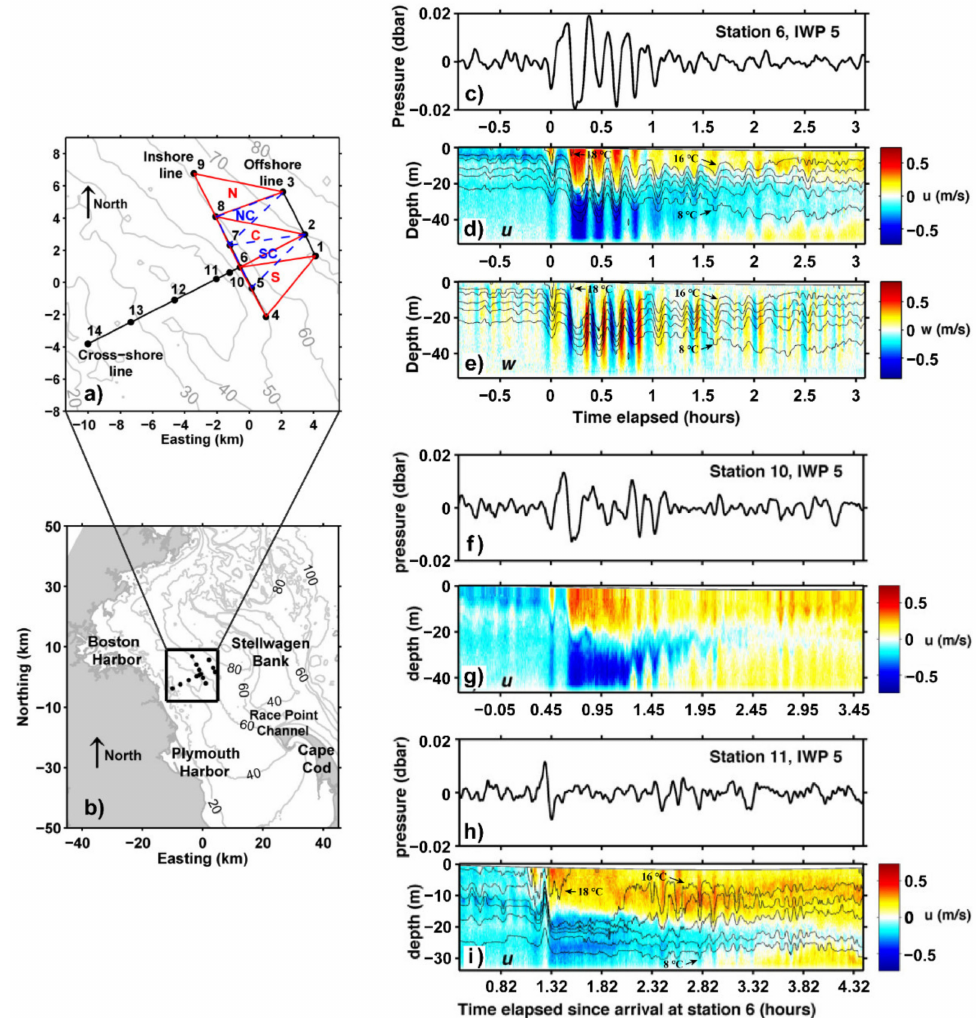
Figure 6. Seafloor pressure variability of the internal wave packet (IWP) in Massachusetts Bay detected by a sensor array. ( a ) Station locations (black dots) of bottom pressure sensors. ( b ) Map of the investigation area in Massachusetts Bay, the black box is ( a ). For IWP 5, comparison between ( c ) filtered bottom pressure, ( d ) horizontal velocity u and temperature, and ( e ) vertical velocity w and temperature at station 6. Comparison between ( f ) filtered bottom pressureand ( g ) horizontal velocity u at station 10. Comparison between ( h ) filtered bottom pressure and ( i ) horizontal velocity u and temperature at station 11. The temperatures in ( d , e , i ) represent black contour lines at 2 ◦ C intervals from 8 ◦ C to 18 ◦ C. Time 0 h is the timing of IWP 5 reaching station 6. Panels ( a – i ) adapted from Thomas et al. [11], with permission from